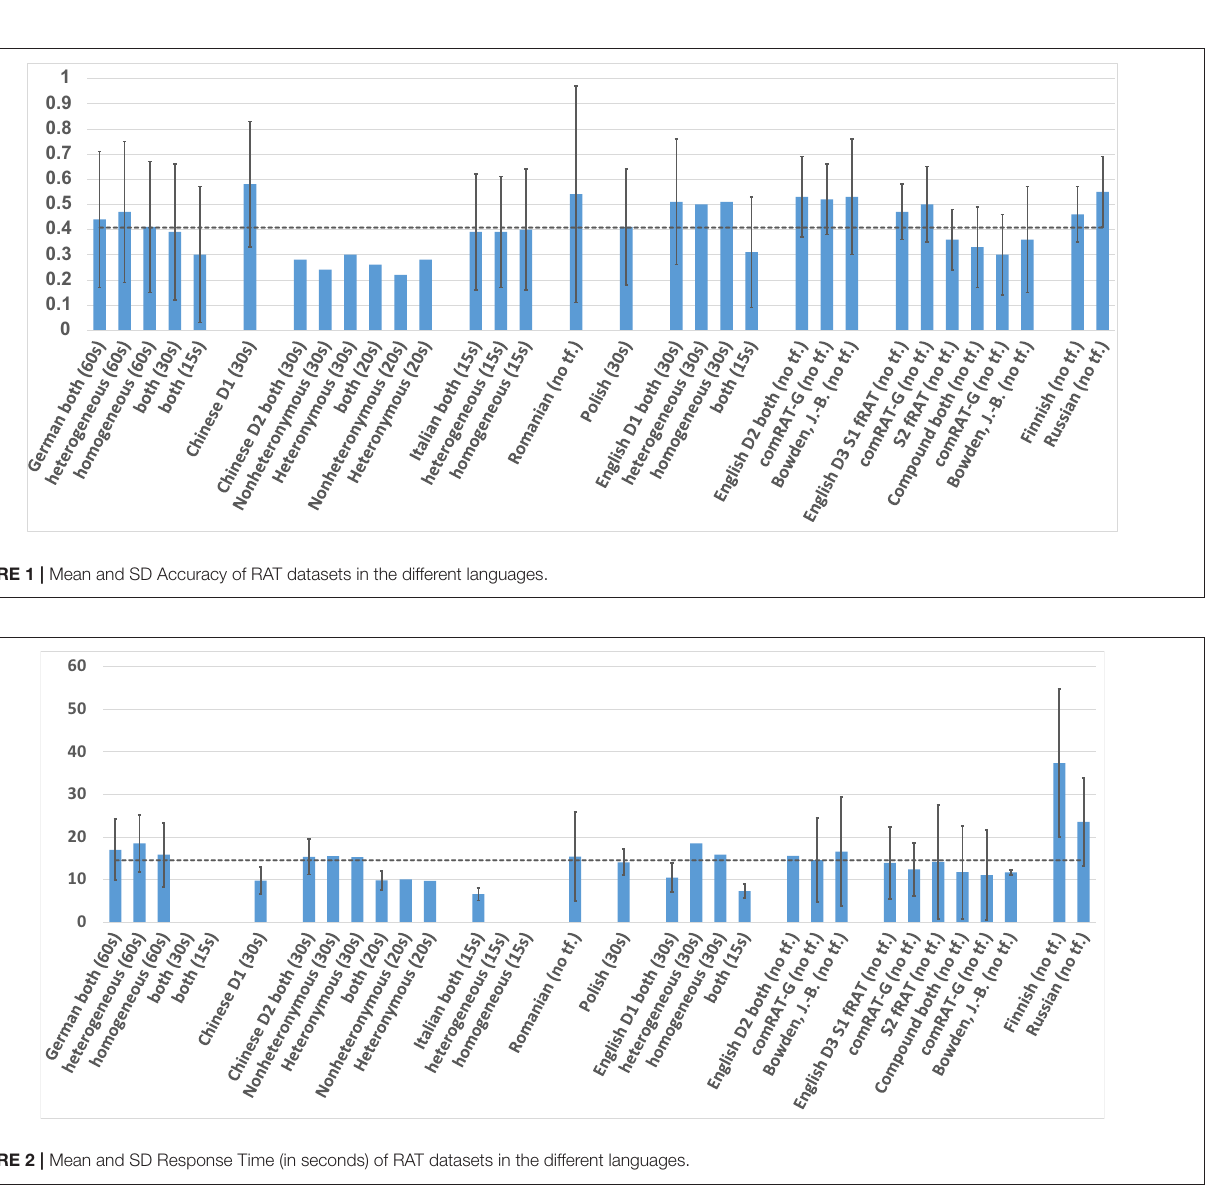
Frontiers in Psychology |